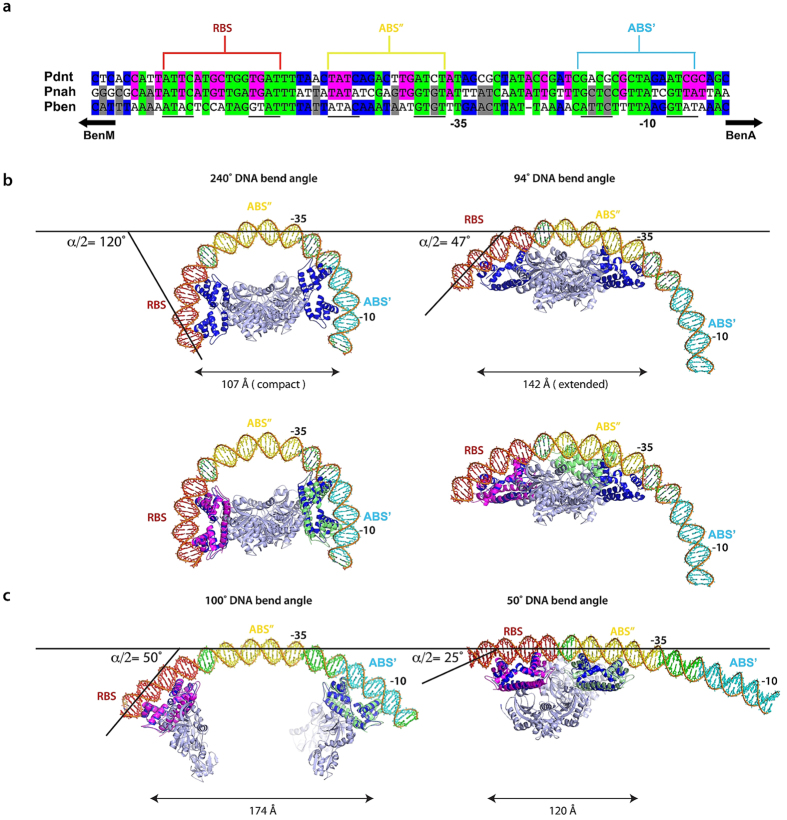
Models of transcriptional activation by homotetrameric LTTRs.(a) Alignment of the operator–promoter regions
pdnt, pnahr and pbenA, indicates that
the DNA binding sites of DntR and BenM are located in similar regions.
(b) Top: Models of the binding of pbenA to the
SAXS-obtained solution conformations of inactive (left) and inactive (right)
DntR homotetramers indicate that a conformational change from compact
(inactive) to more extended (active) homotetramers would result both in a
switch in DNA binding sites and a relaxation (240o to
94o) in the bend of operator–promoter region
DNA. Bottom: As for the top panel but also showing the predicted DNA binding
regions for the wHTH domains (magenta and green) of the LTTR BenM.
(c) Models of pbenA with smaller bending angles and how
LTTRs might bind to these. Left: For promoter-operator region DNA with a
100o bend, simultaneous binding of RBS and
ABS’ (separated by ~174 Å)
regions cannot be achieved if a LTTR maintains a homotetrameric
conformation. Right: For promoter-operator region DNA with a
50o bend, simultaneous binding of RBS and
ABS” (separated by ~120 Å)
can be achieved by a homotetrameric LTTR although this will have a
conformation very different to that described here for activated
(holo-) DntR.